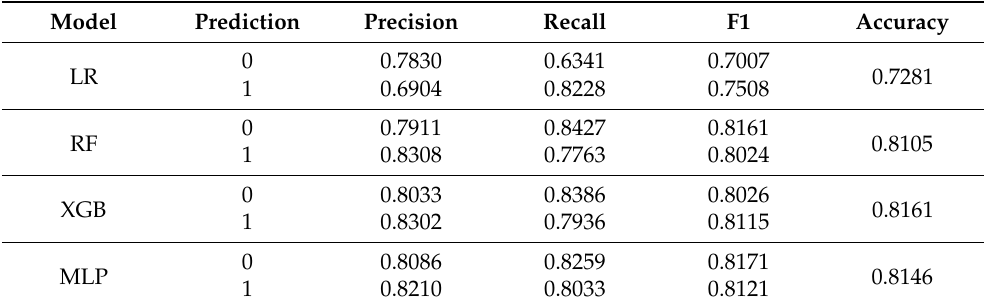
Table 2. Accuracy metric for evaluating classification models. The highest accuracies (in bold) are from XGBoost and MLP.